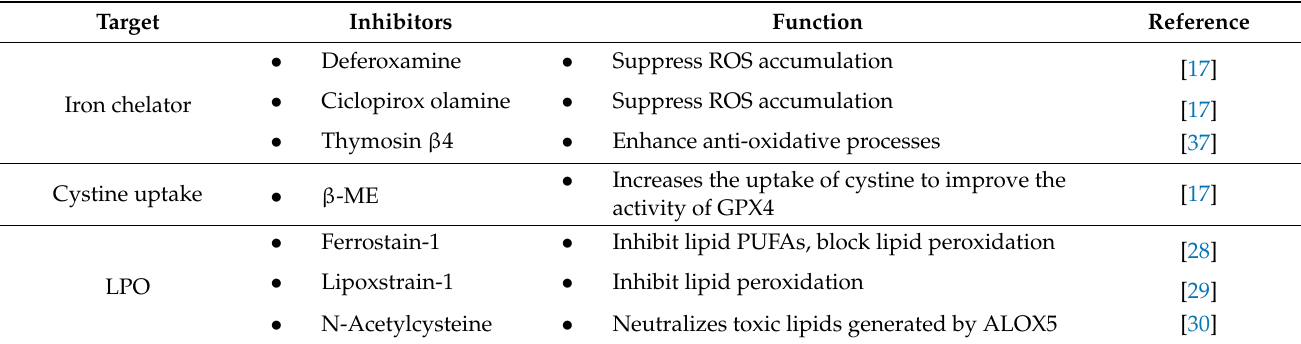
Table 2. Main ferroptosis